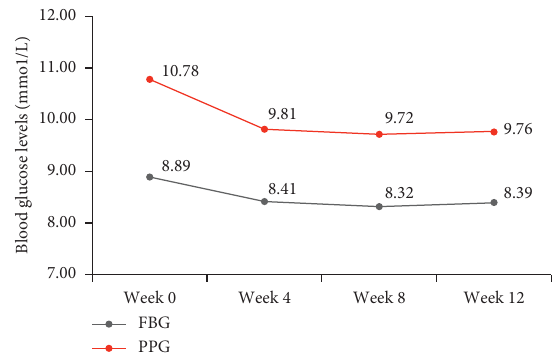
Figure 2: FBG and PPG profiles form baseline to week 12. Mean BG levels are presented. FBG, fasting blood glucose; PPG, post- prandial